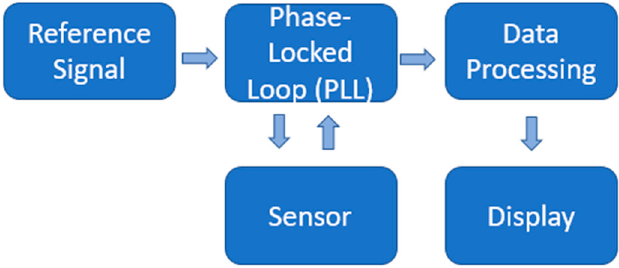
Figure 3. A schematic design of the sensing system.